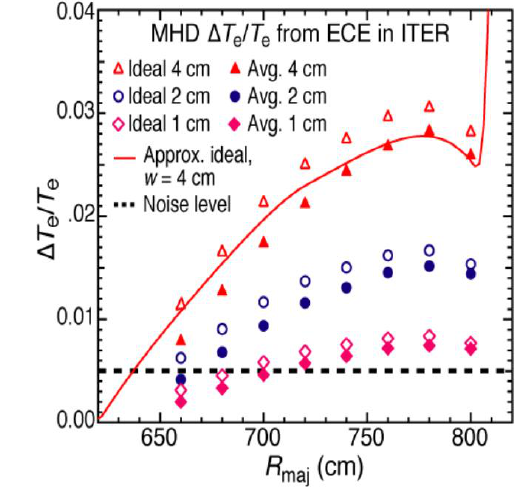
Fig. 1. Expected ΔTe/Te from rotating MHD islands. Correlation technique could be used to get even better resolution. Note: ITER plasma major radius is 6.2 m.